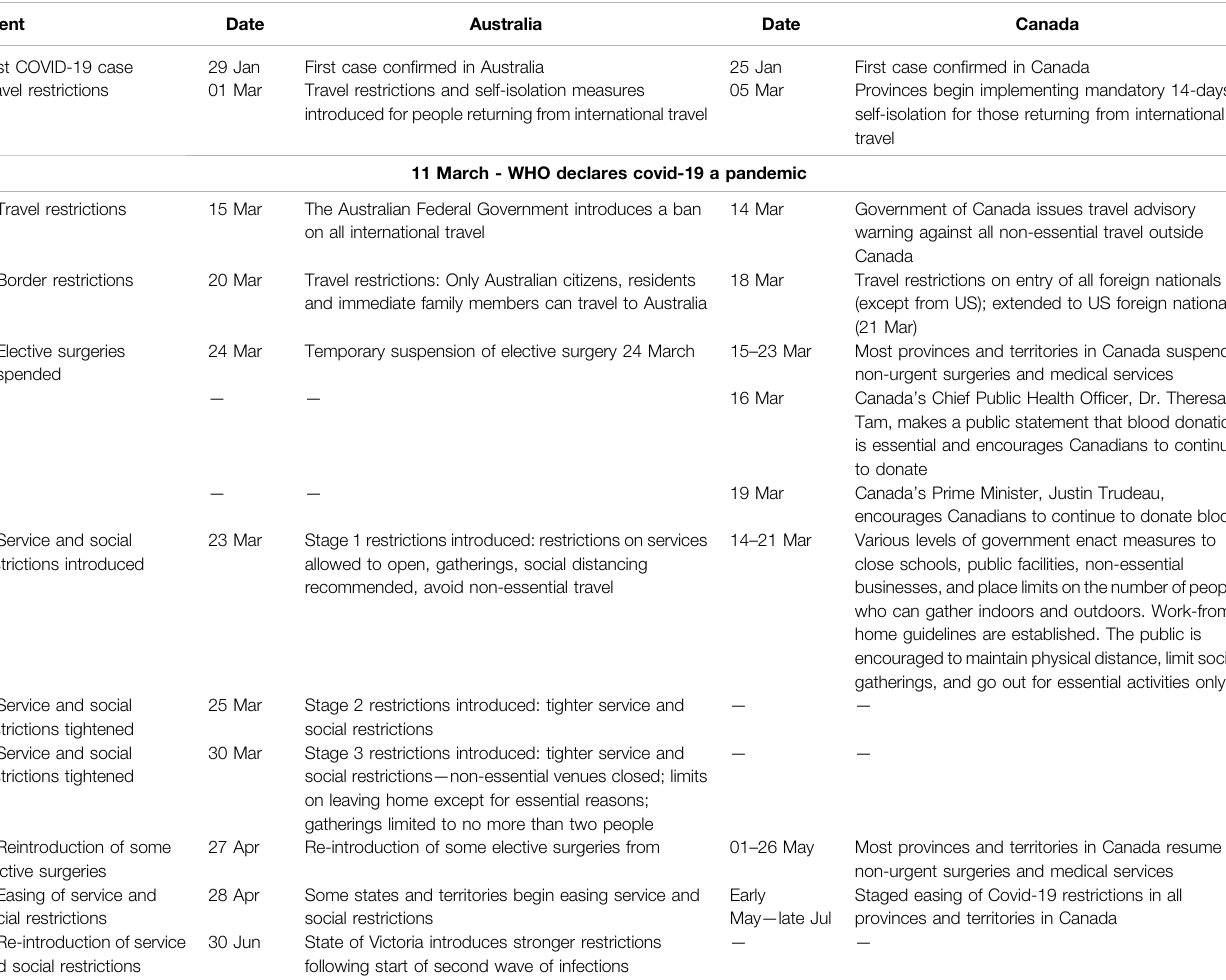
TABLE 1 | Covid-19 public health and government responses in Australia and